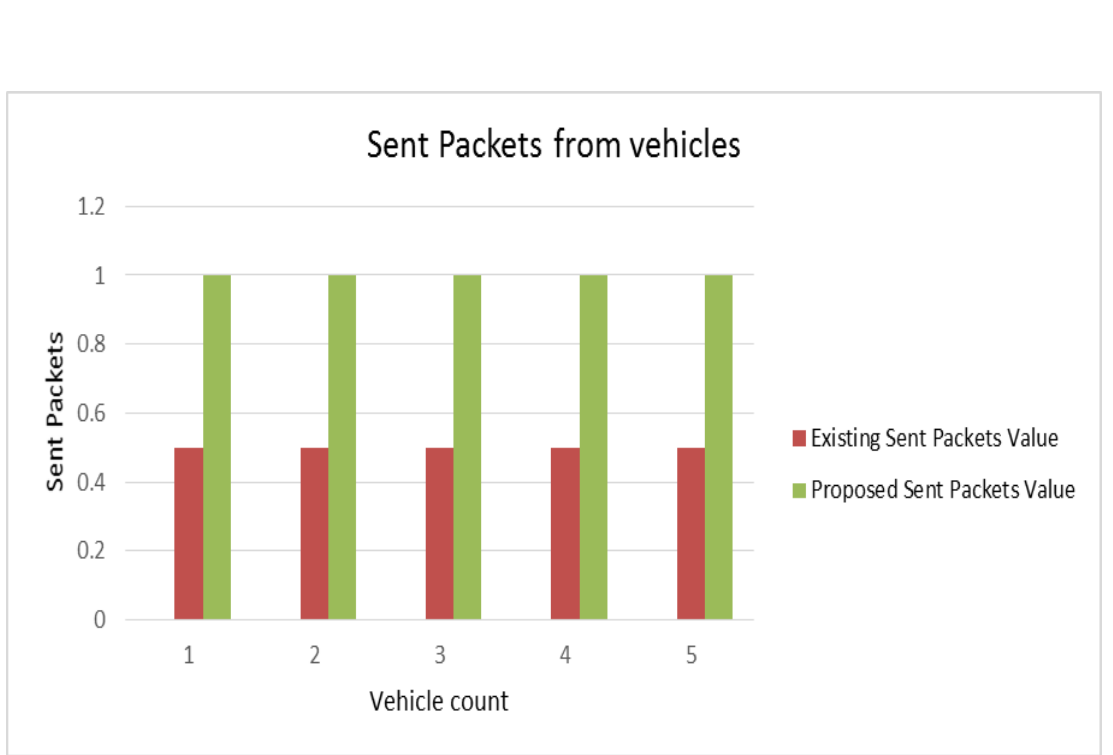
Figure 12. Sent Packets from vehicles